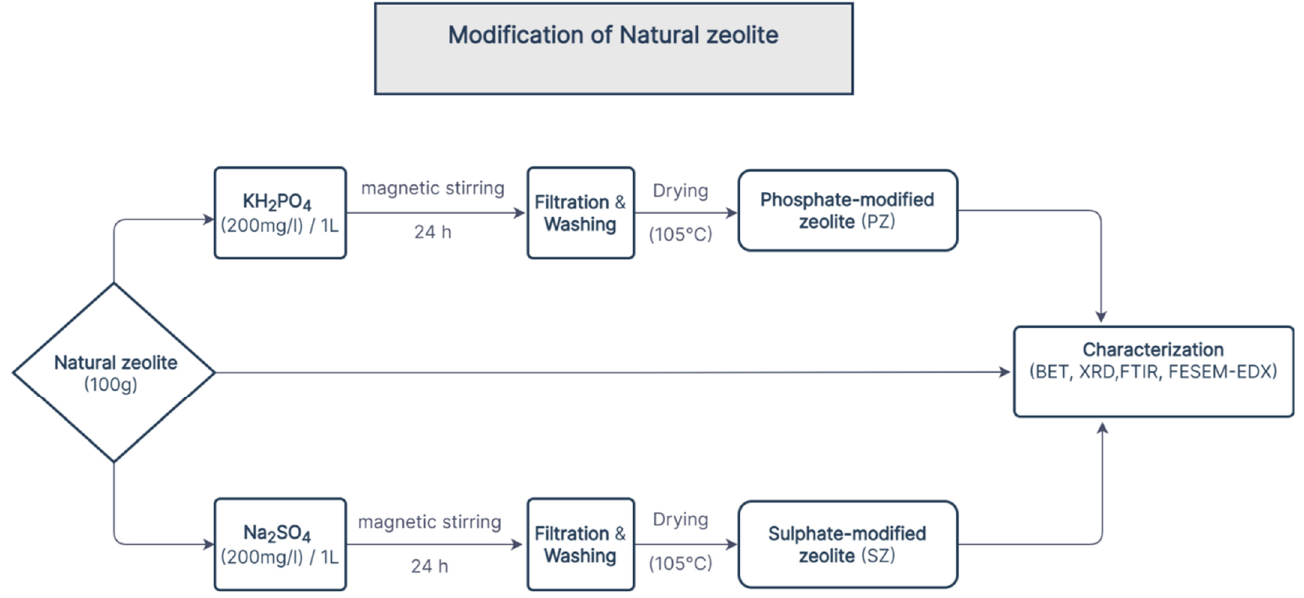
Figure 1. Simplified flowchart illustrating the modification procedure of natural zeolite using sulphate and phosphate.